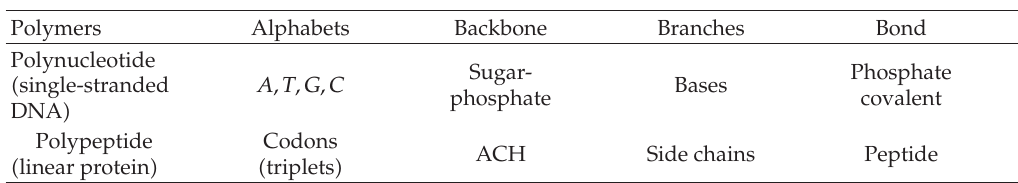
Polymers Alphabets Backbone Branches Bond Polynucleotide Sugar- Phosphate (cid:3) single-stranded A,T,G,C Bases phosphate covalent DNA (cid:4) Polypeptide (cid:3) linear protein (cid:4) Side chains